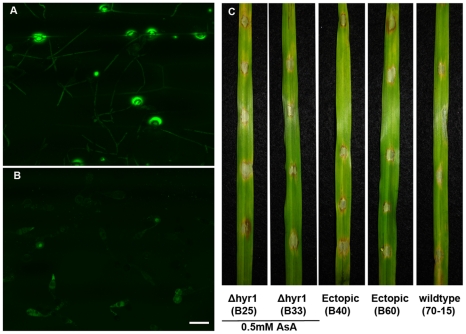
ROS scavenging in the plant rescued the hyr1 mutant
phenotype.(A) Conidia of Δhyr1 (B25) were mixed
with 0.5 mM ascorbic acid and inoculated onto the leaf surface. Infected
leaves were stained for ROS 24 hpi. (B) Conidia were mixed
with water and inoculated onto the leaf surface. Leaves were first
treated with 0.5 mM ascorbic acid for 1 hour and stained for ROS 24 hpi.
(C) From left to right: Δhyr1 (B25),
Δhyr1 (B33) (where susceptible barley leaves were
treated with 0.5 mM ascorbic acid for 1 hour and then inoculated with
mutant spores in water) ectopic (B40), ectopic (B60), wild type (70-15).
Scale bar  = 20 µm for all confocal
images.